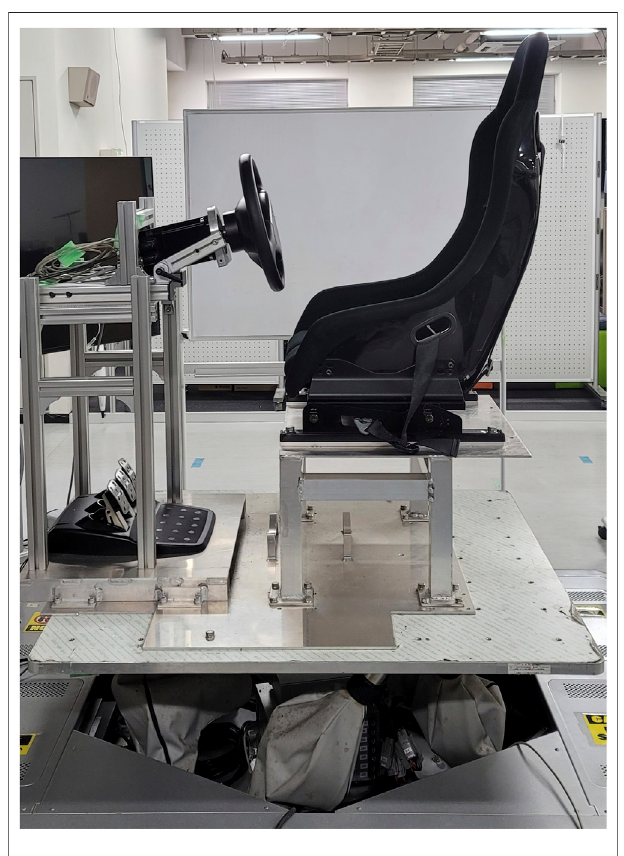
FIGURE 1 | Vibration